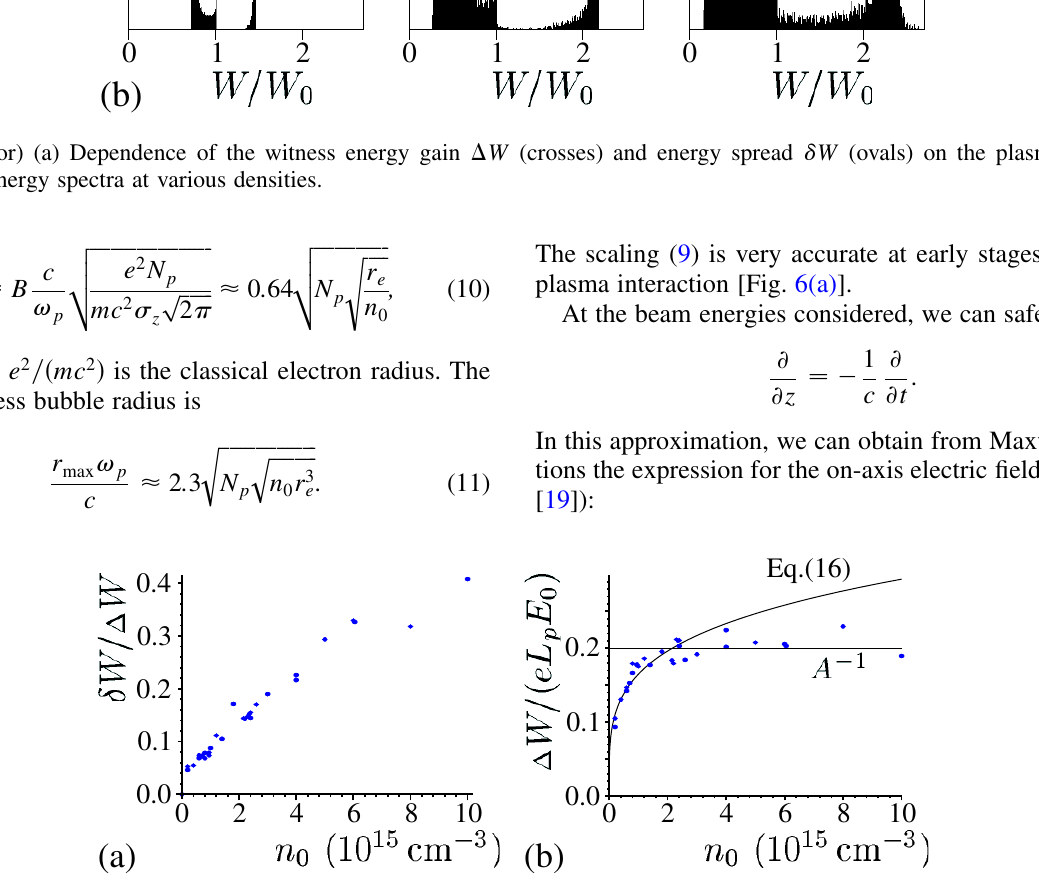
FIG. 5. (Color) Dependence of the relative witness energy spread (a) and dimensionless average accelerating rate (b) on the plasma